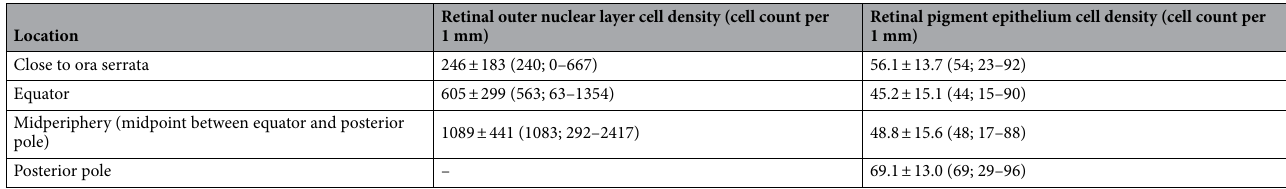
Table 1. Count of the cells in the retinal outer nuclear layer and count of retinal pigment epithelium cells (per mm; mean ± standard deviation; median; range).